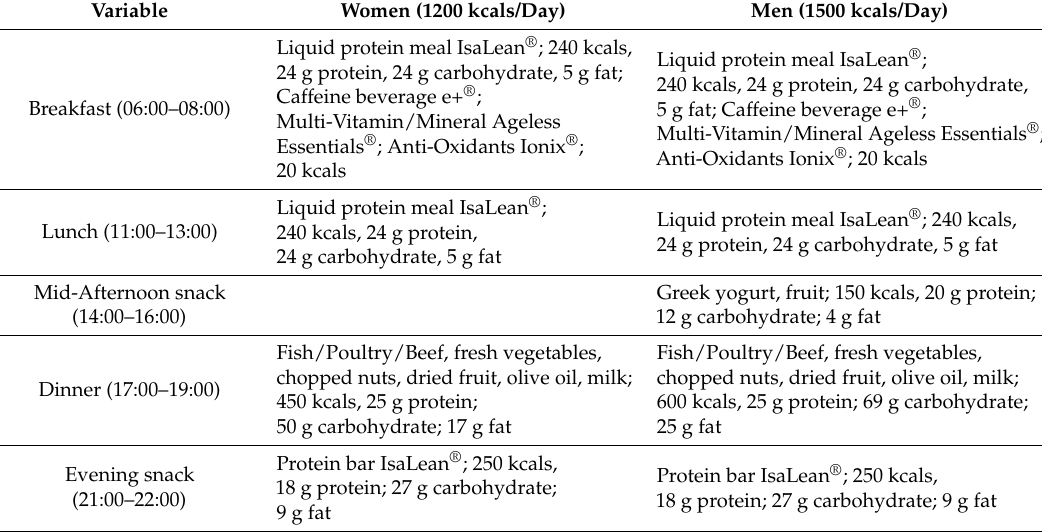
Table 1. Sample menus and meal timing for women and men during WL phase (Protein-pacing/ caloric-restriction, P-CR; Weeks 0–12). Menus were isocaloric for all women and men, respectively.